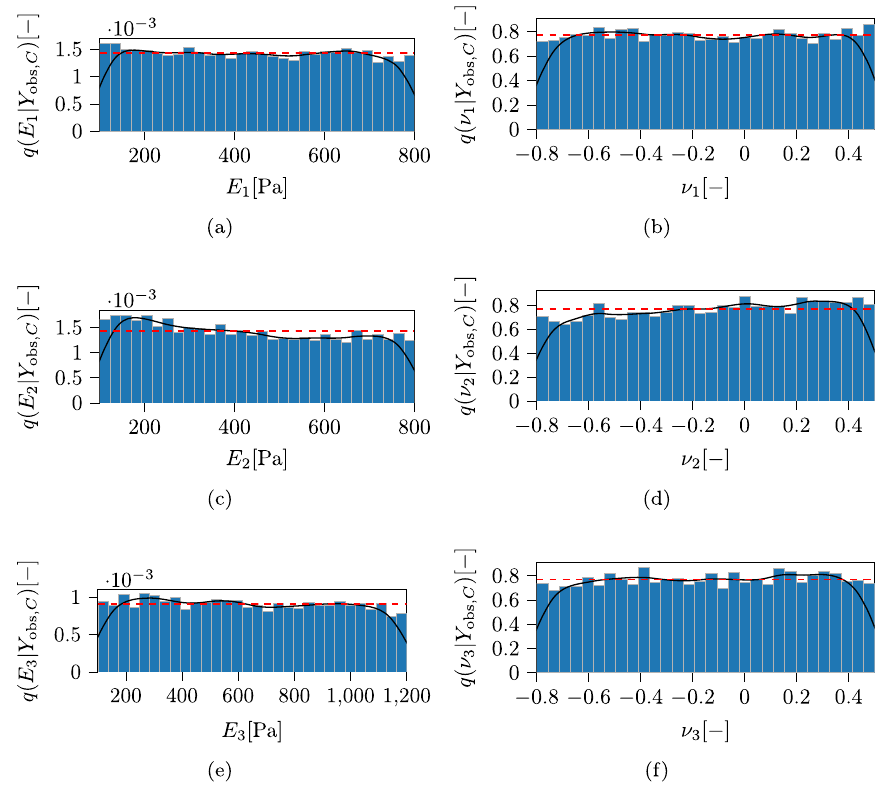
Fig. 13 Marginals of the posterior for a – f individual parameters in heterogeneous example with uncertain inflow condition with added Gaussian noise and uniform prior as red dashed line. Marginals as histograms (blue) with a KDE approximation (black)